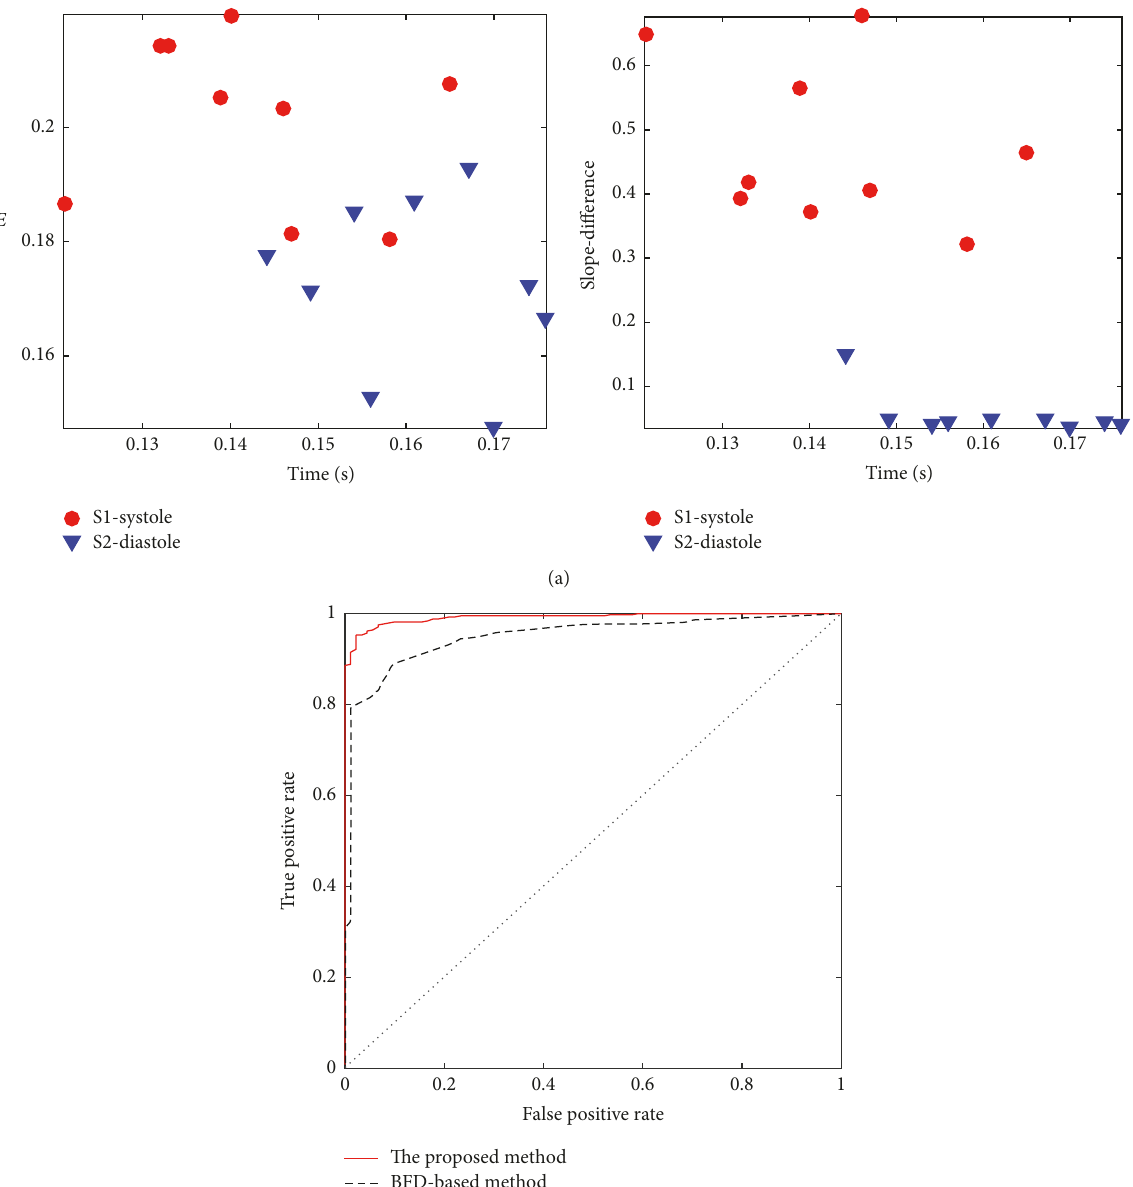
Figure 6: (a) S1-systole and S2-diastole differentiation using the standard and the slope-difference approach. (b) ROC curves of the proposed and fractal based